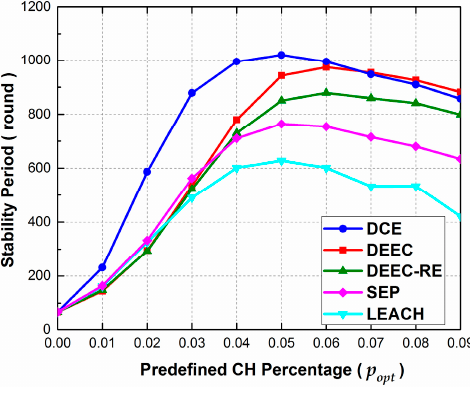
Figure 6. The effect of predefined percentage of cluster heads (cid:1868) (cid:3042)(cid:3043)(cid:3047) on stability period in Scenario 3. When (cid:1868) (cid:3042)(cid:3043)(cid:3047) = 0.00, sensor nodes in all the protocols transmit the sensed data to BS directly and